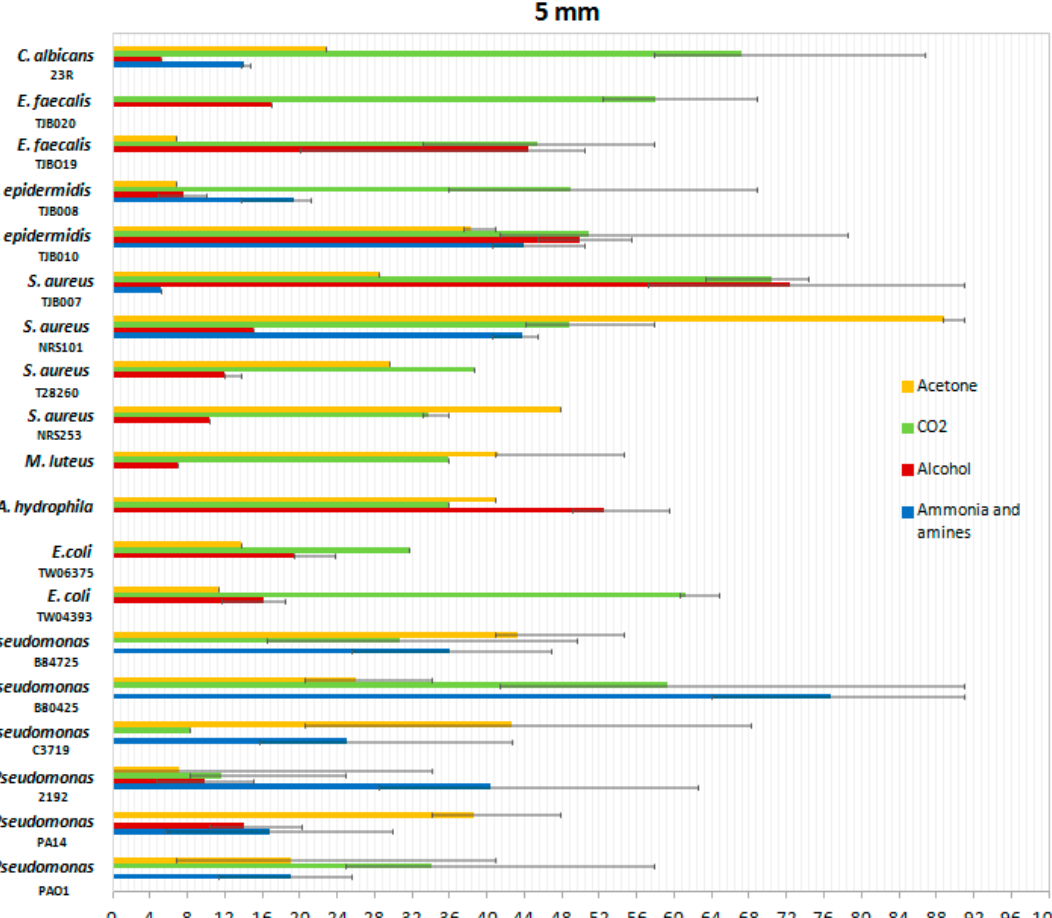
Figure 10. Responses normalized from 0 to 100 by each sensor separately, dividing each value by the maximum in all the maximum in all the bacteria.